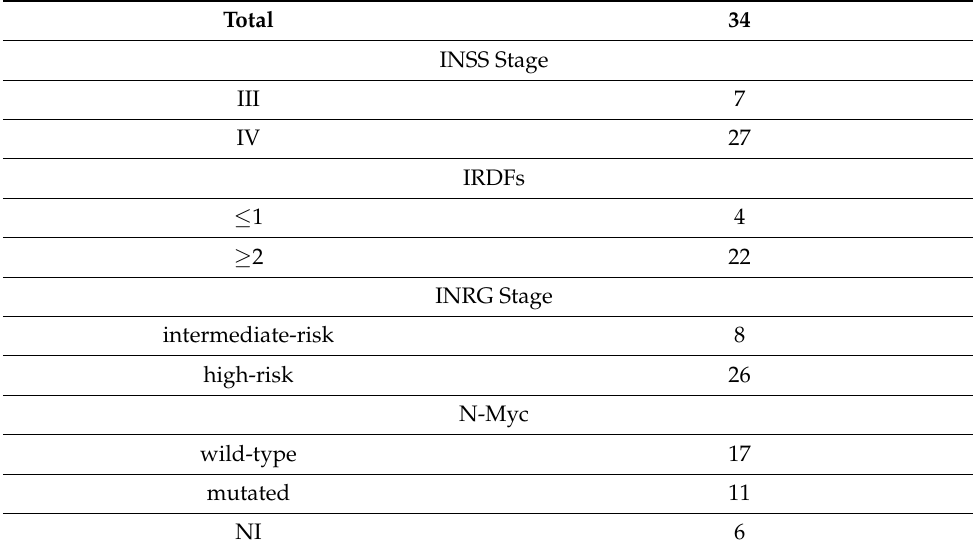
Table 1. Distribution of patients by INSS, IRDFs, INRG, and N-Myc status. Total 34 INSS Stage